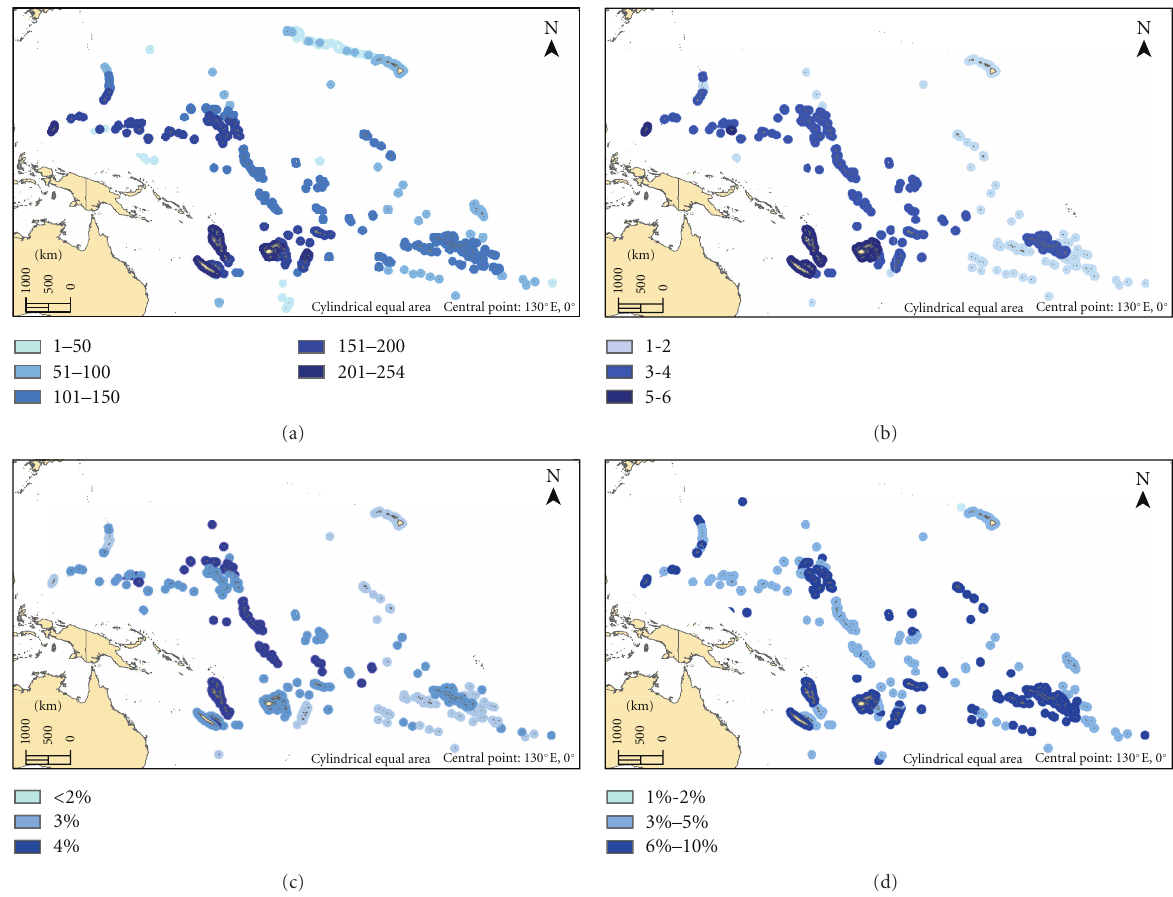
Figure 4: (a) Species richness of bony coral reef fish species assessed in Oceania, (b) species richness of bony shore fish species assessed in threatened categories (Critically Endangered, Endangered, or Vulnerable), (c) proportion of all bony coral reef fish species assessed in threatened categories, and (d) proportion of all bony coral reef fish assessed as Data